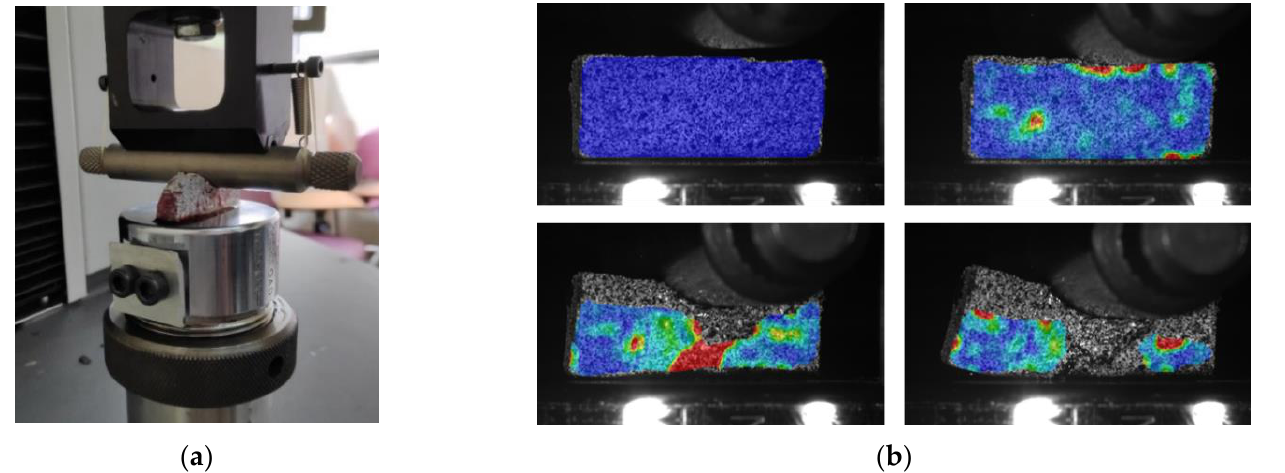
Figure 6. Roller indentation test: ( a ) prismatic trabecular bone sample during test; ( b ) strain measures by DIC techniques